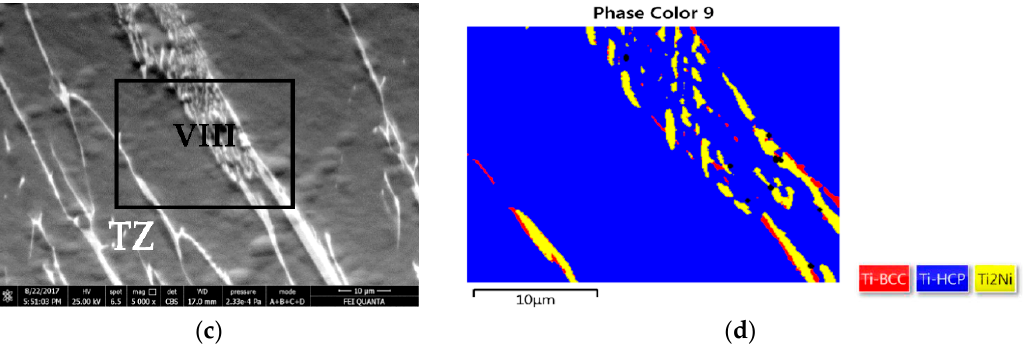
Figure 7. SEM/EBSD analysis results of the joint brazed at 1200 °C for 600 s: ( a ) BEI of the BZ, ( b ) EBSD phase distribution map of location VII in ( a ), ( c ) BEI of the TZ, ( d ) EBSD phase distribution map of location VIII in ( c ).